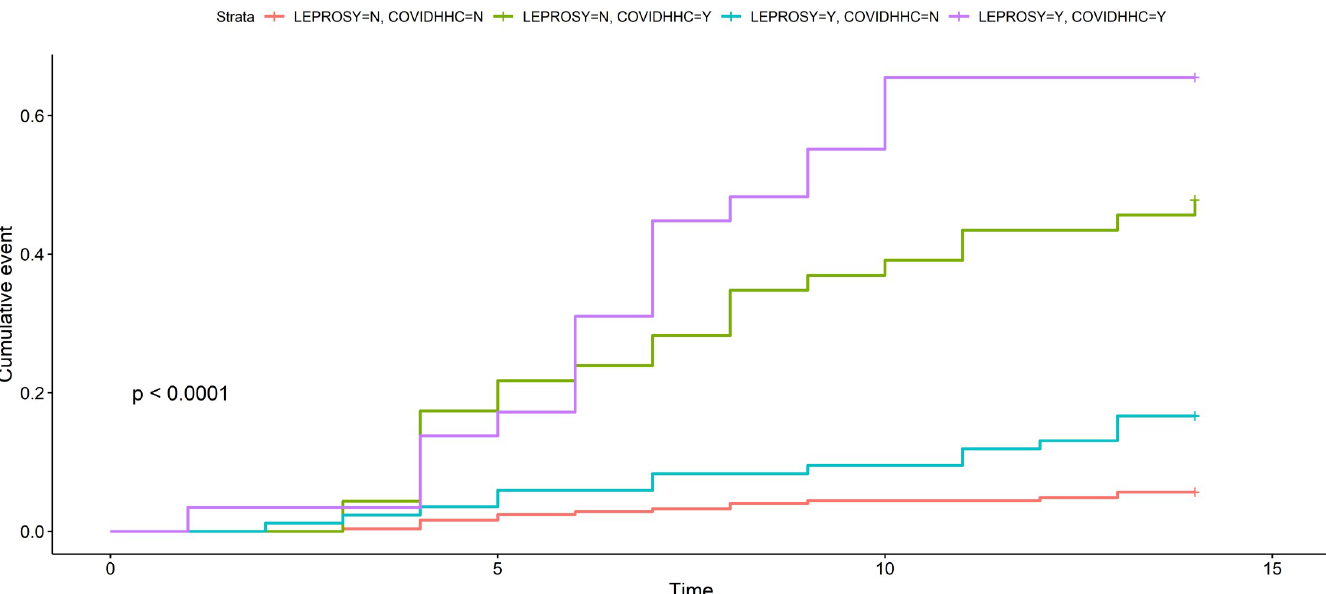
Fig 2. Survival curves adjusted for active leprosy and COVID-19 positive household contact representing possible risk factors for the occurrence of COVID-19. N = no, Y = yes, HHC = household contacts.